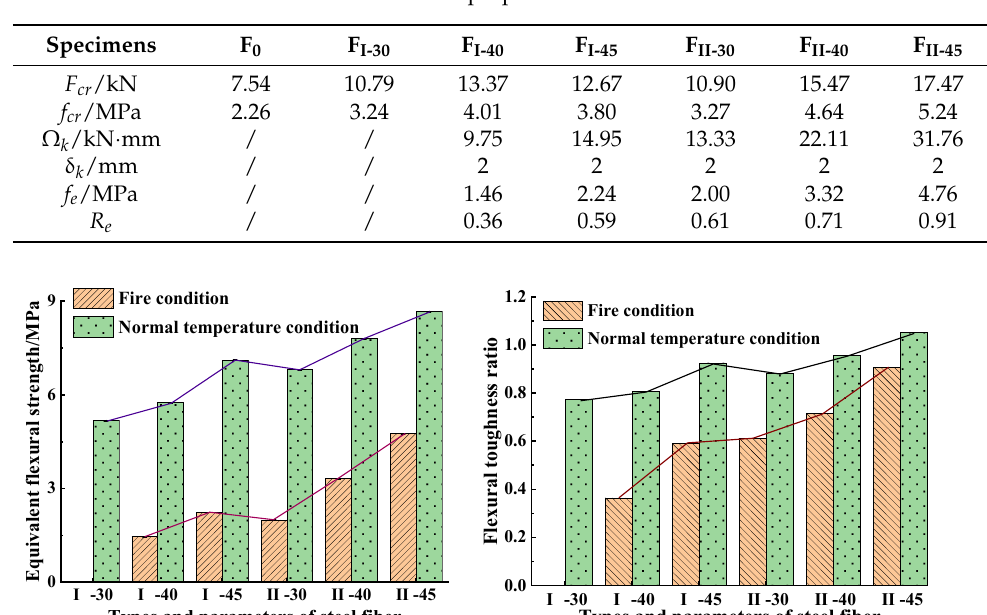
Table 8. Calculation results of the mechanical properties of SFRC after fire.